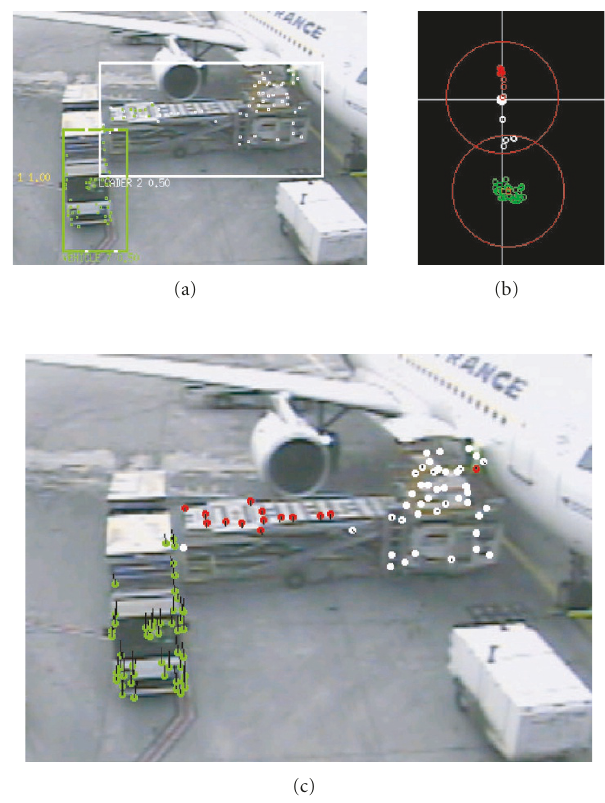
Figure 4: (a) Sample frame from Dataset S28-Camera 5 showing two merged vehicles: a transporter vehicle moving towards the cam- era, and a stationary loader vehicle with its platform being raised upwards. (c) Segmentation of the features of the two vehicles by fit- ting motion models and clustering: the features of the transporter are explained by a single motion model, while those of the loader are explained by two main motion models (a main motion model with weights 0 . 68 for the stationary loader and a secondary motion model with weight 0 . 26 for the loader’s platform). (b) The motion models as plotted in the motion parameter space and after perform- ing